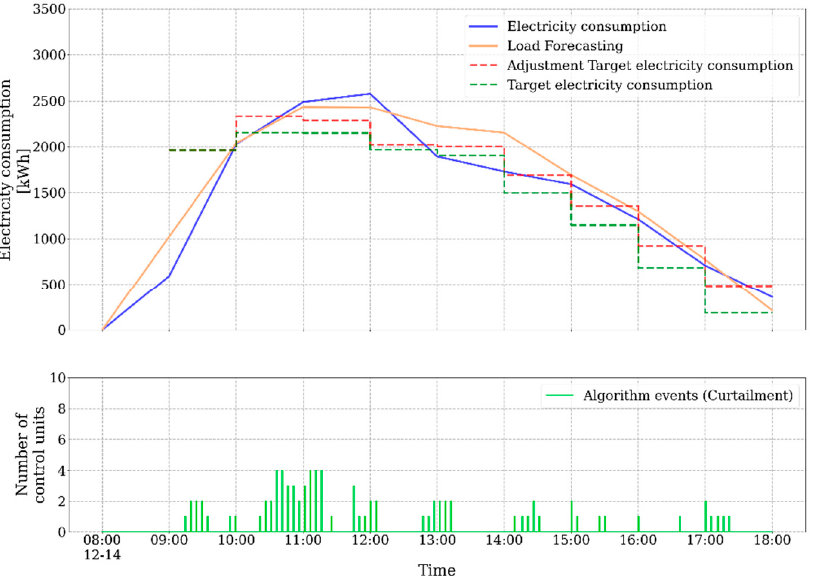
Figure 16. Reduction ratio 5% result of the field test with the target, building electricity consumption, and algorithm events applying the building control algorithm.